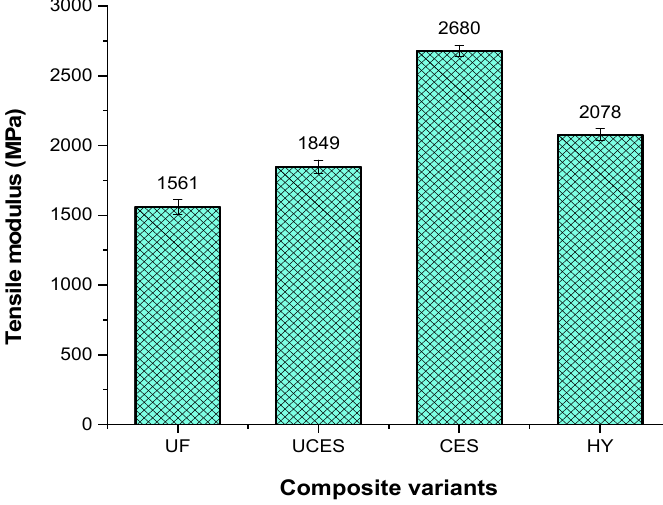
Figure 5. Tensile modulus comparison of composite variants.